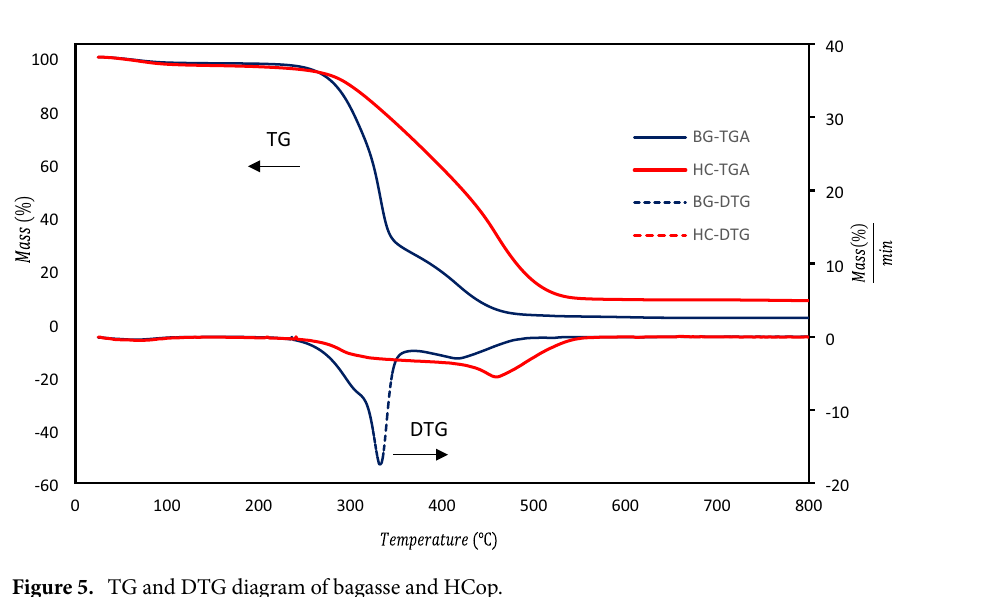
Figure 5. TG and DTG diagram of bagasse and HCop.